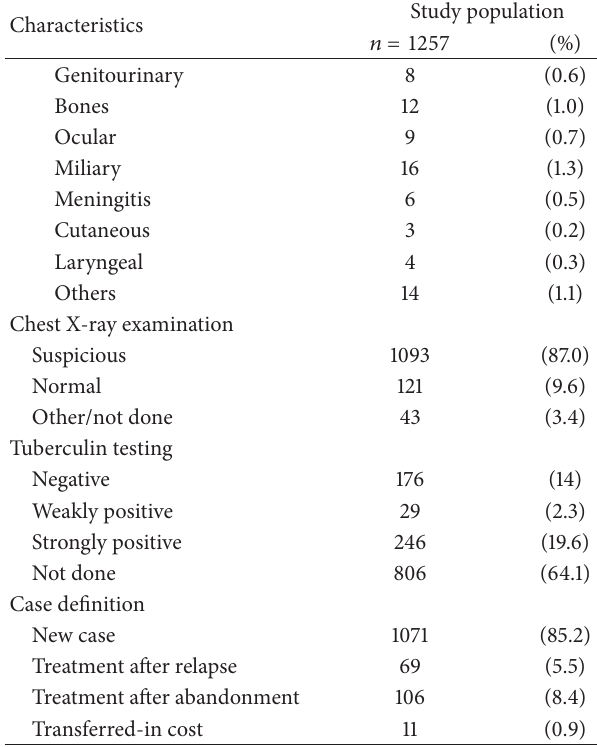
Table 1: Characteristics of patients with